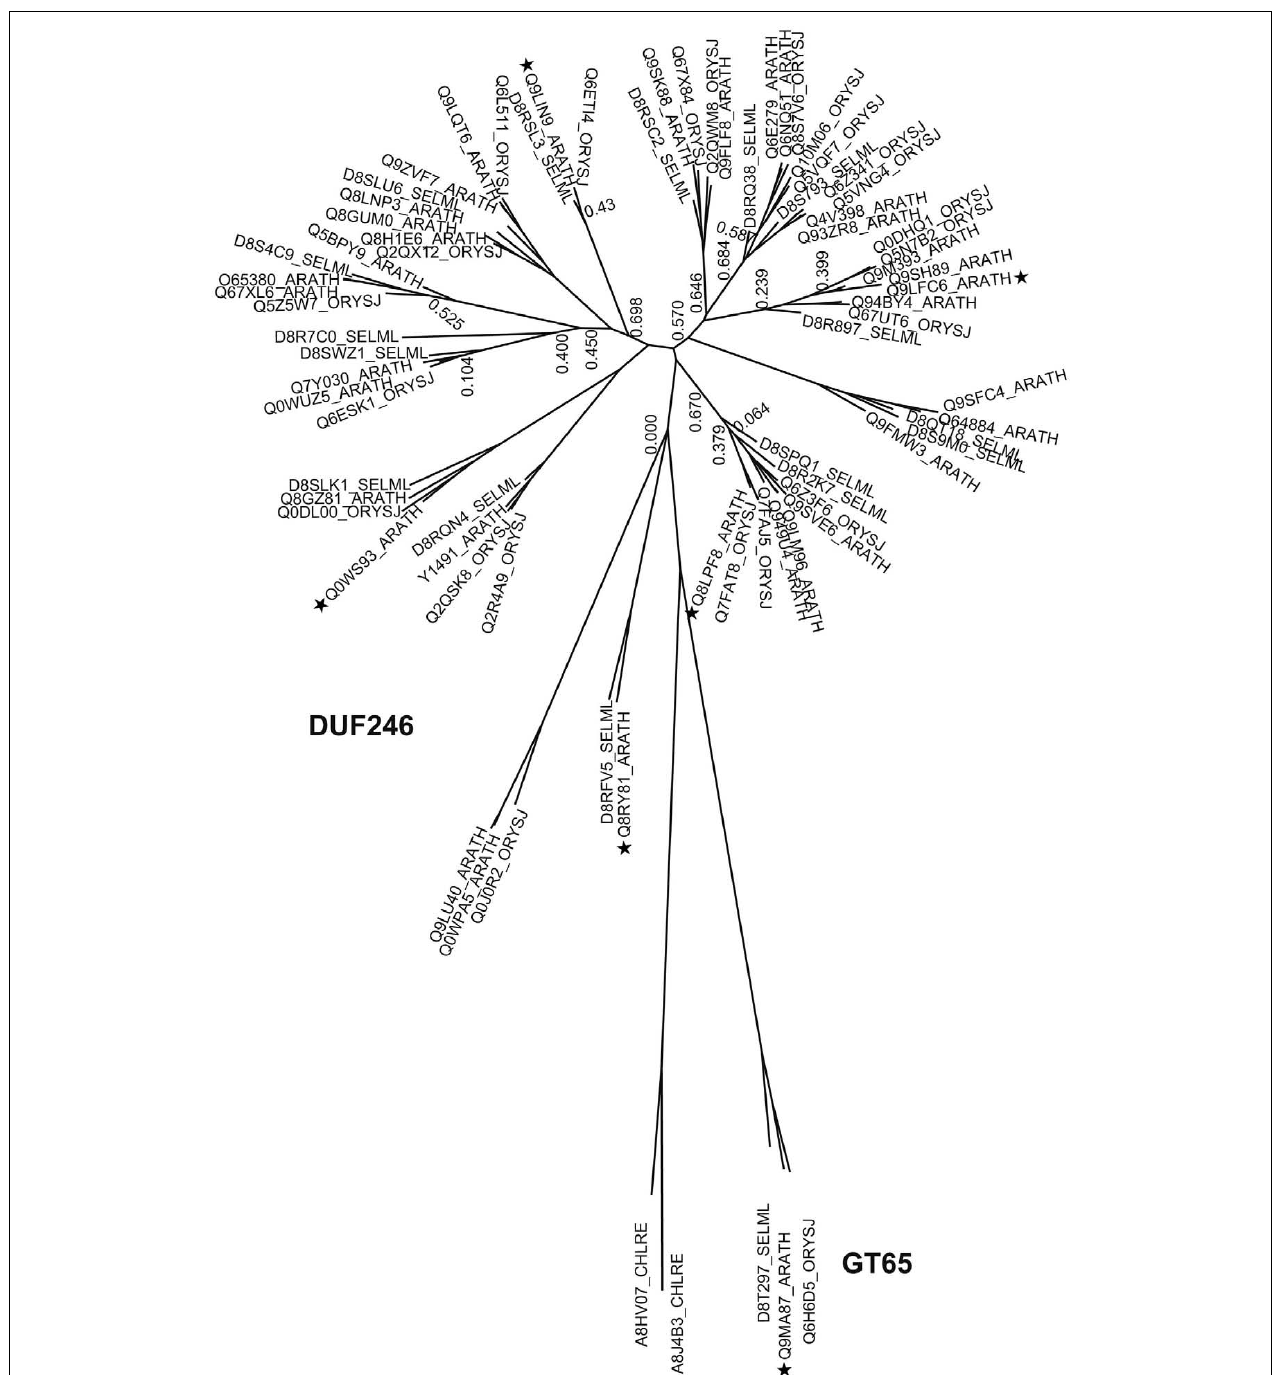
using http://www.phylogeny.fr (Dereeper et al., 2008). Following sequences 8QTM0, D8SPE4, D8TE31, Q0DBZ9, Q53PH8, Q5N9U3, Q651P4, Q653G2, and Q7XAB1 were omitted from the tree due to sequence mistakes, mainly intron/exon border malpredictions. Asterisks indicate the selected sequences of the multi alignment displayed in FigureA4